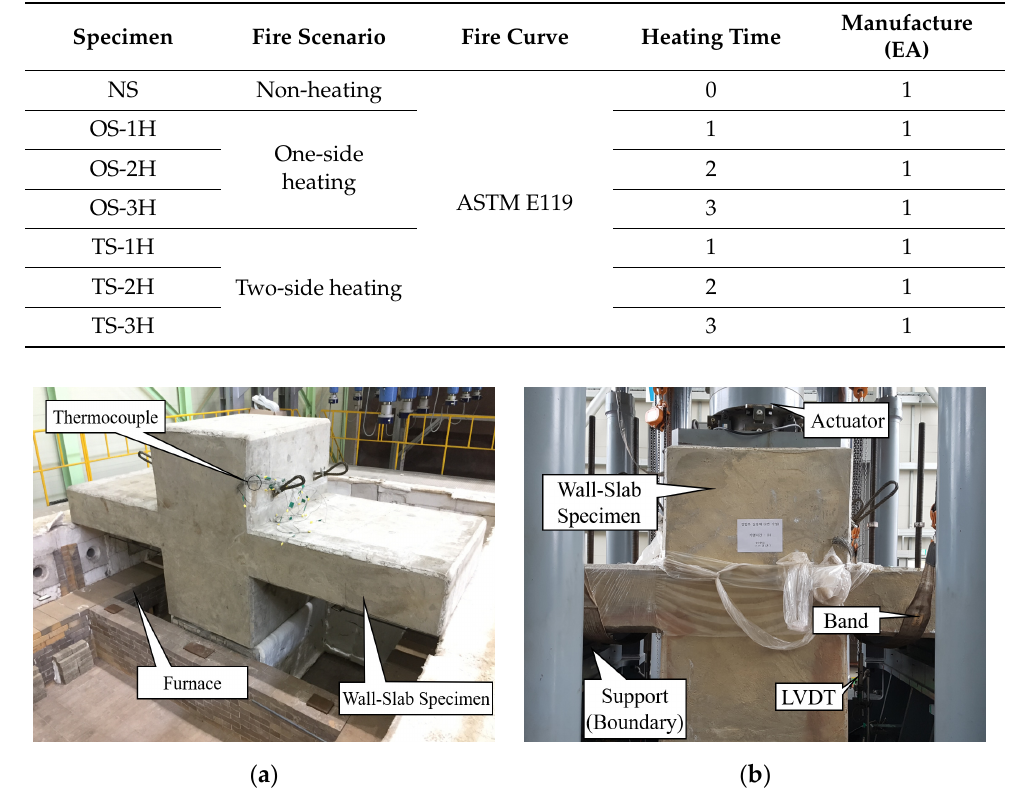
Materials 2021 , 14 , x FOR PEER REVIEW Figure 5. Wall-slab specimen test setting: ( a ) Heating furnace; ( b ) actuator.